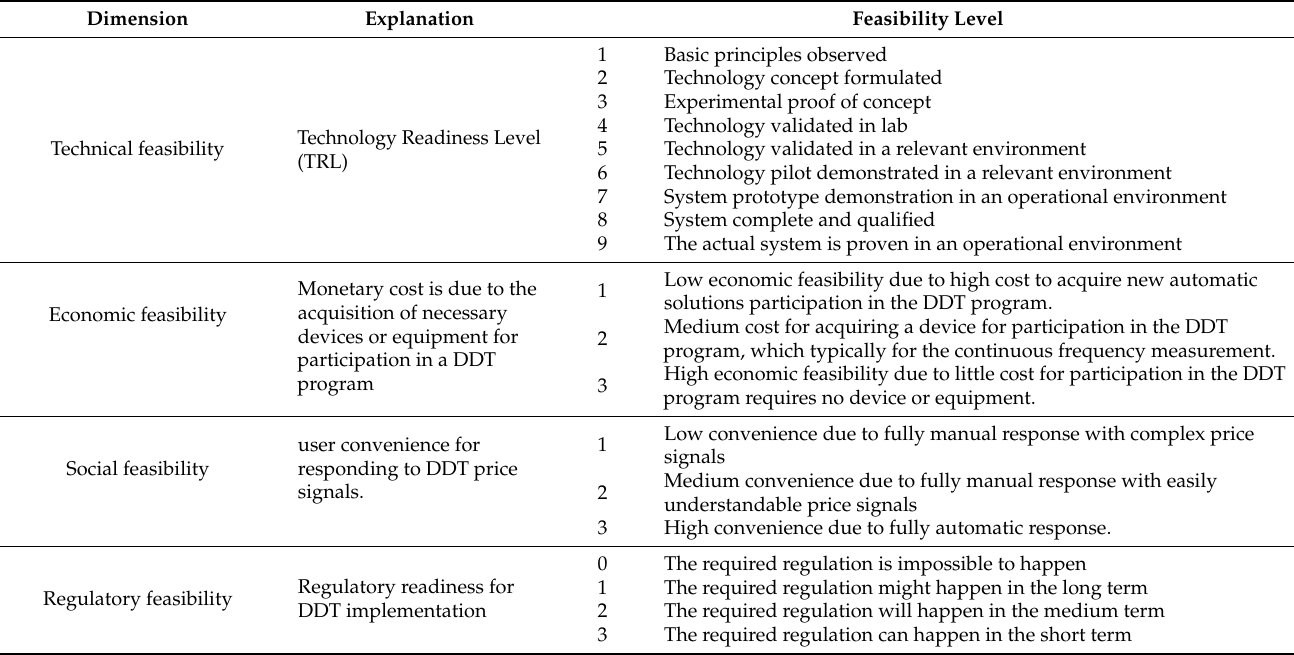
Table 9. The technological, economic, social, and regulatory feasibility evaluation method for dynamic distribution tariffs.